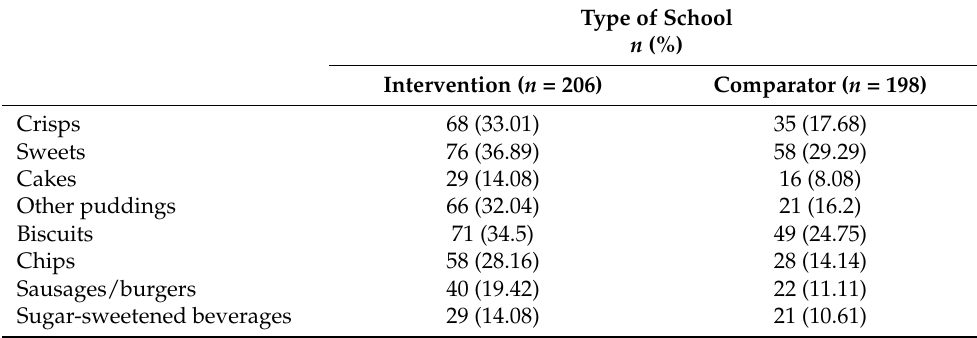
Table 5. Consumption of unhealthy foods and drinks (most days, every day or >every day).